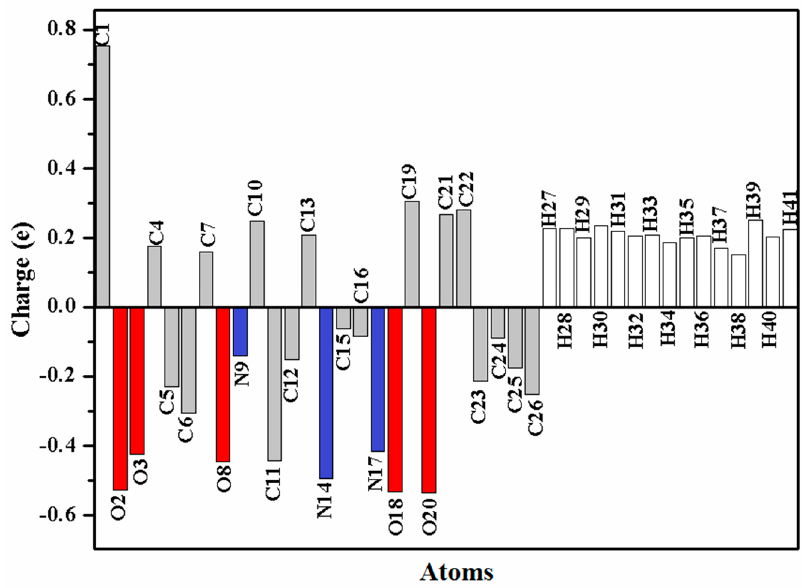
Figure 3. The atomic charge distribution of the oximino ester 5 .